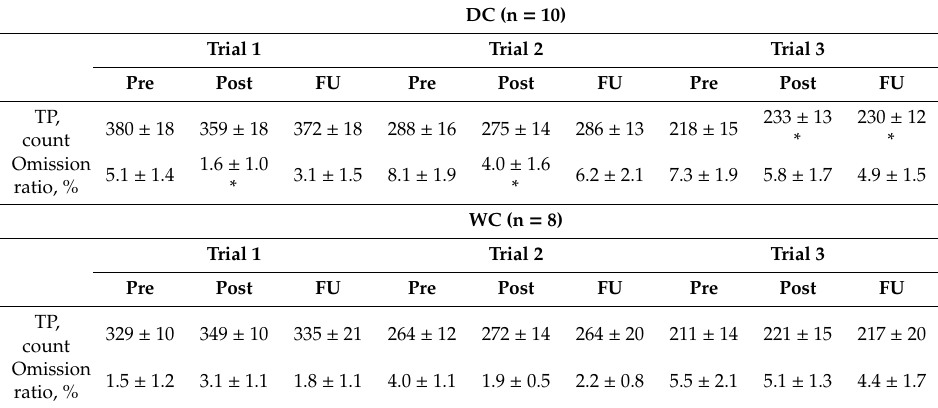
Table 2. D-CAT at Pre, Post and FU for the DC and WC